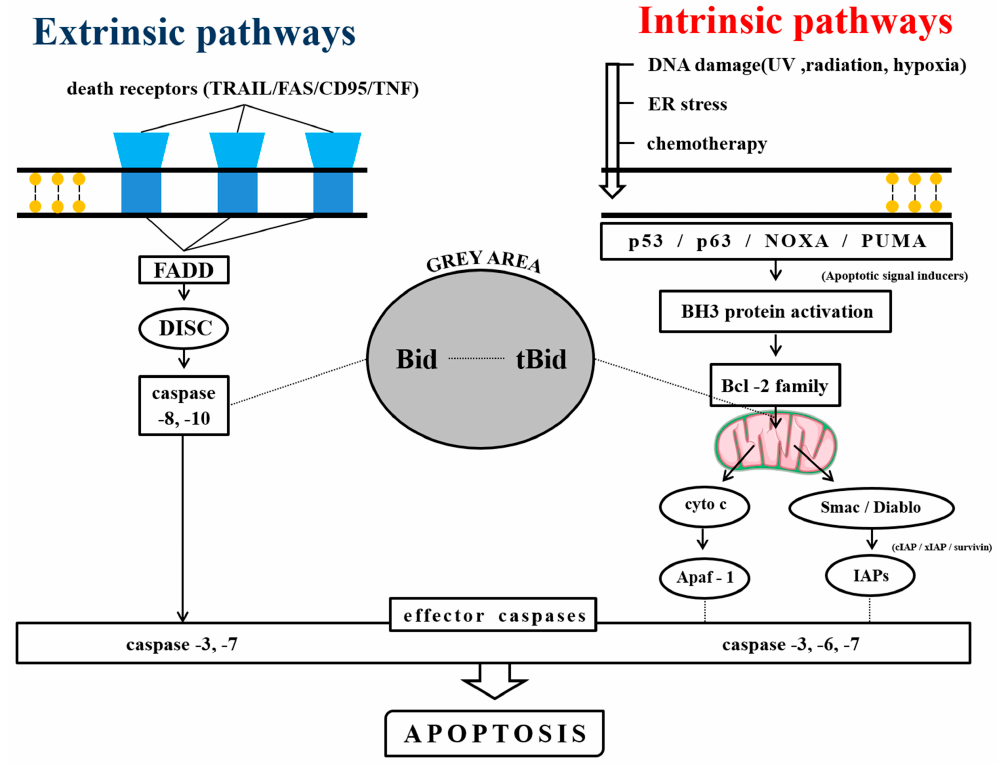
Figure 1. The extrinsic and the intrinsic pathways of apoptosis. The left side shows the extrinsic pathway and its mediating factors. The right side shows the intrinsic pathway and its activating mechanism. The grey area in the middle shows the controversial area of Bid proteins. Int. J. Mol. Sci. 2019 , 20 , 2302 The intrinsic pathways are mainly controlled by the proteins of Bcl-2 family (Figure 2). There are mainly two subcategories; antiapoptotic proteins (Bcl-2 subfamily cohort) and proapoptotic proteins (Bax subfamily cohort and BH3 subfamily cohort) [33].